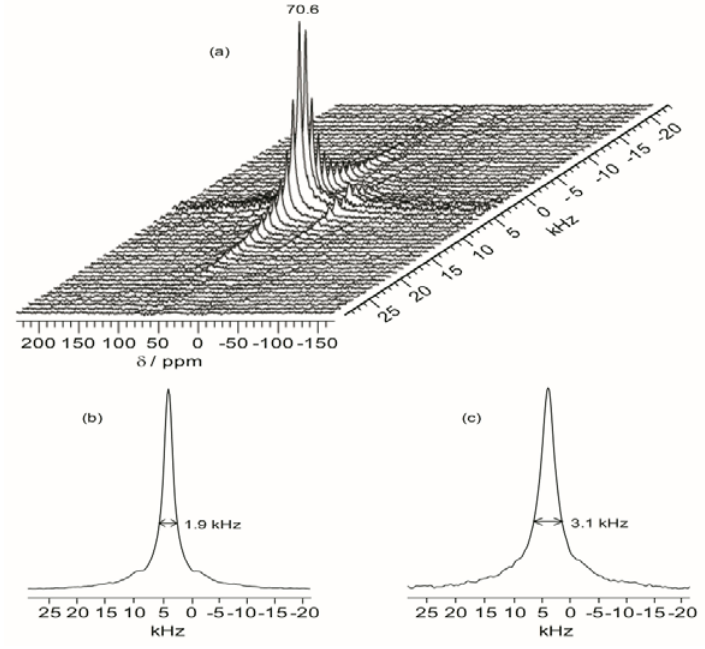
Figure 7. Representative 2D 1 H– 13 C wide-line separation (WISE) NMR spectrum ( a ) and the projections of the 1 H dimension of 2D 1 H– 13 C WISE spectra associated with the 70.7 ppm peak in the 13 C dimension for TIE(600)-Z hybrids, where Z = ( b ) 32 and ( c )